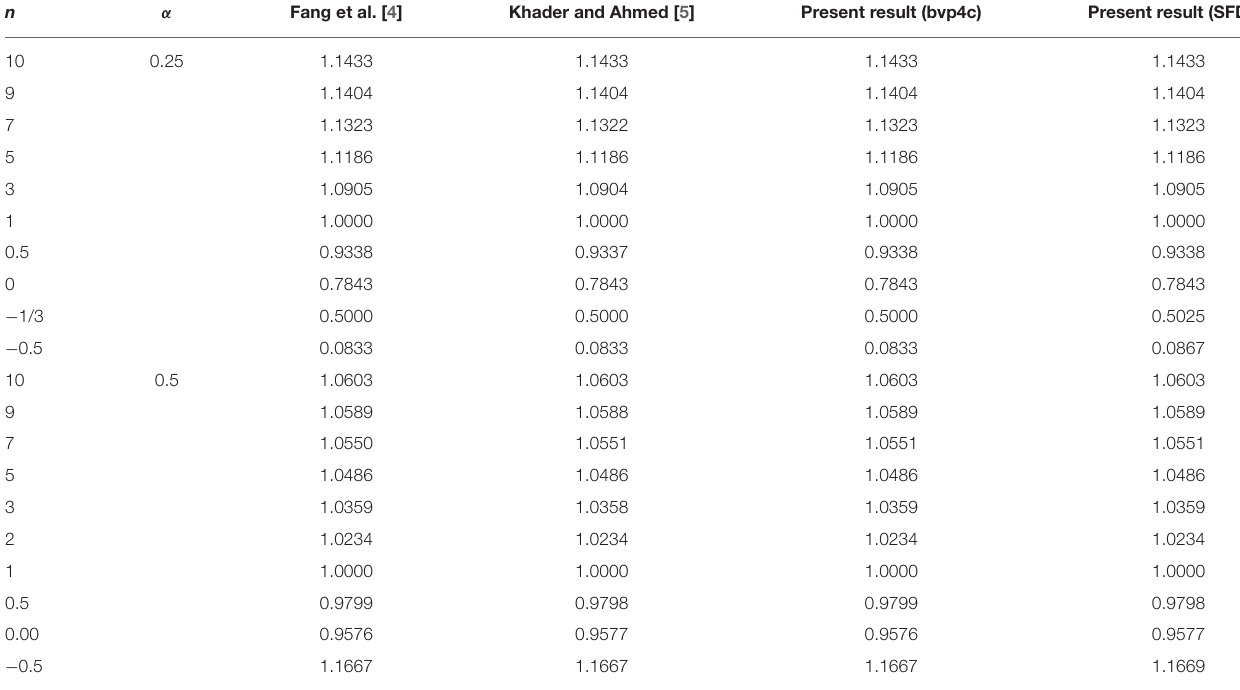
TABLE 1 | Resemblance of − f ′′ (0) from the literature for various n values ( CASE A ).